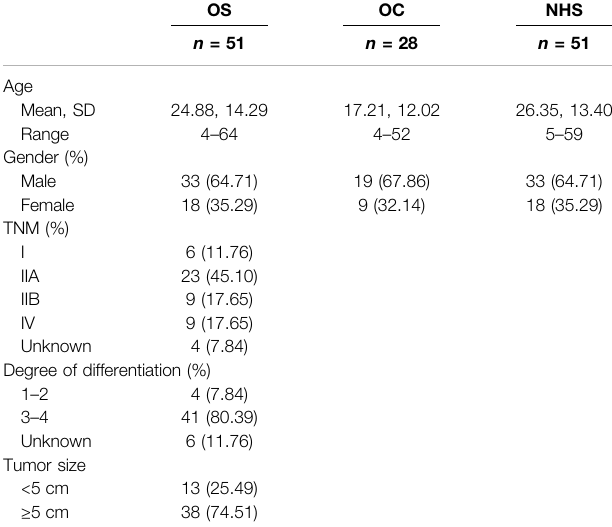
TABLE 1 | Basic clinical characteristics of OS, OC, and